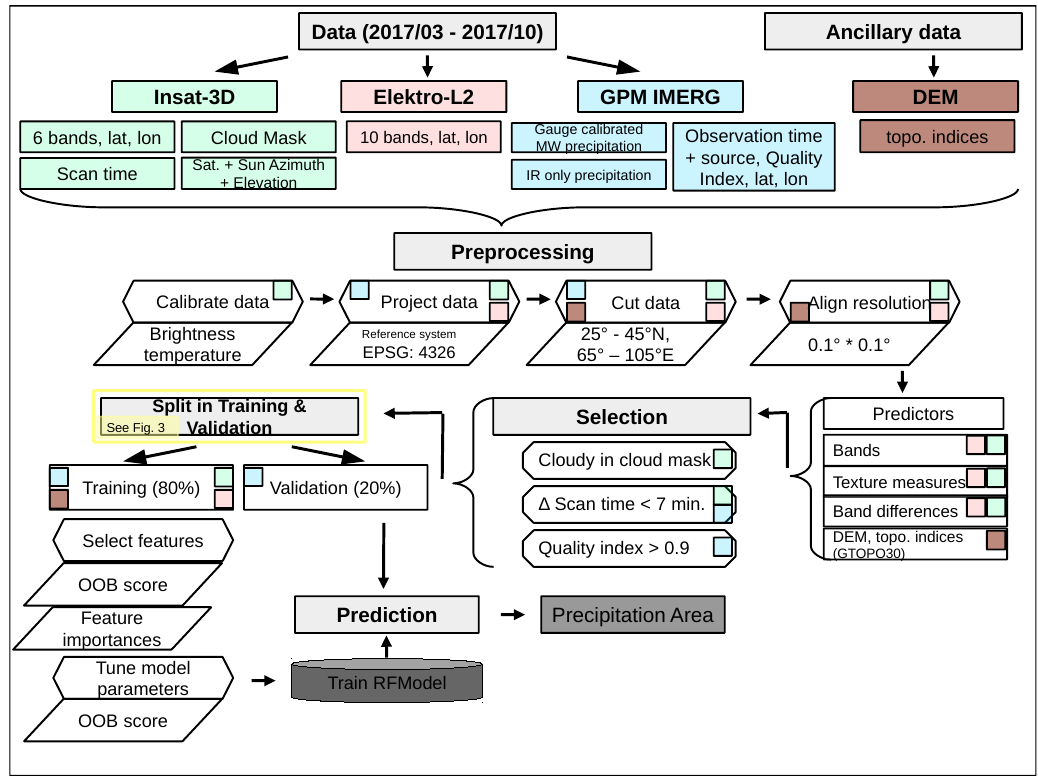
Figure 2. Schematic view of the processing scheme of the precipitation area